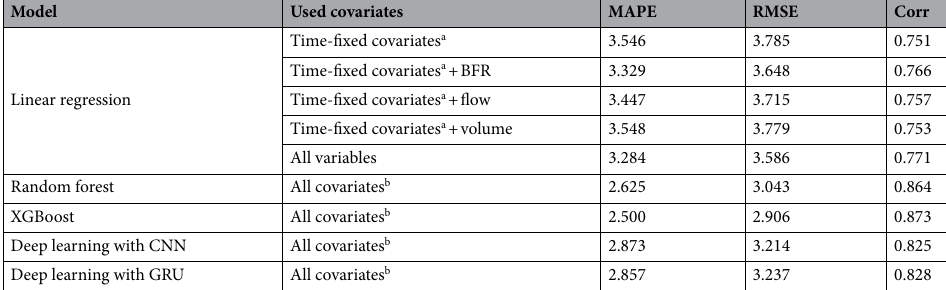
time-fixed covariates, BFR, dialysate flow rate, and ultrafiltration volume.